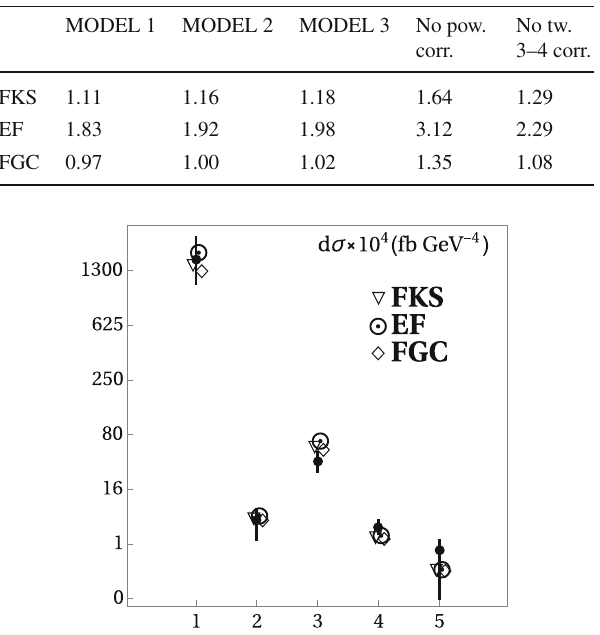
Fig. 2 Comparison of values of cross-section evaluated in MODEL 1 with different iso-spin coupling parameters to the values of measured cross-section